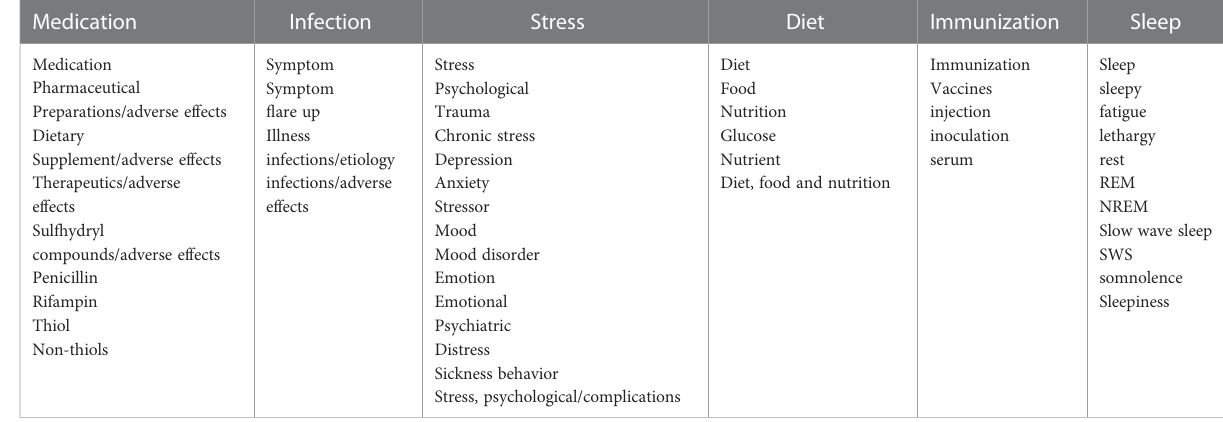
TABLE 1 Keyword terms utilized in database search string for Term